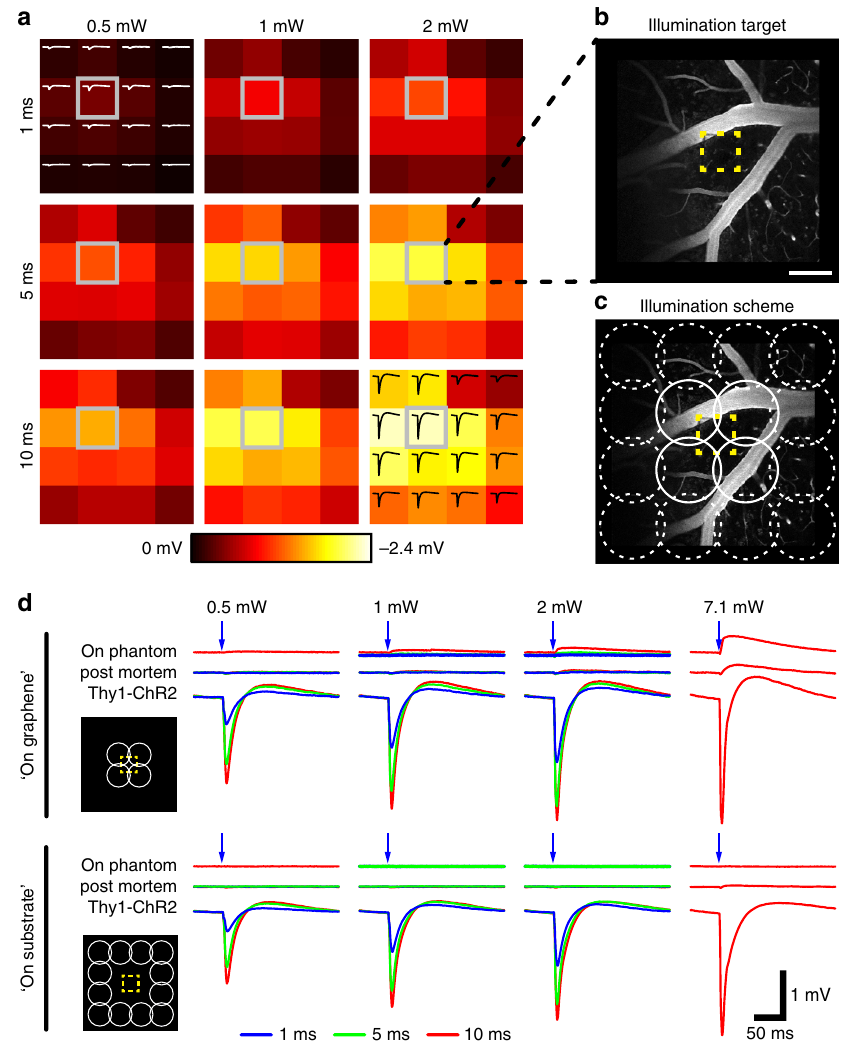
Fig. 5 Measurement of optogenetic photostimulation-induced electrical potentials in Thy1-ChR2 mice that express channelrhodopsin-2 (ChR2) in layer-V pyramidal neurons. a A 473 nm laser beam (diameter: 210 µ m full-width half-maximum) was sent through a 20× objective next to one graphene electrode (highlighted in gray). Different illumination times (1, 5, and 10 ms) and powers (0.5, 1, and 2 mW) were used. Heatmaps represent maximal response amplitude of the 16 electrodes in the array; example traces are shown for 0.5 mW/1 ms (top left) and 2 mW/10 ms (bottom right). b Two-photon image of the illumination target after intravascular injection of FITC-dextran (2 MDa); the yellow outline indicates the position of the graphene electrode. Scale bar, 100 µ m. c Per condition, illumination with the 473 nm laser beam was targeted to 12 sites “ on substrate ” (circles with broken lines) and to four sites “ on graphene ” (circles with closed lines) where the laser beam directly irradiates part of the electrode (yellow outline). d Electrical response of the single graphene electrode within the illumination target in a live Thy1-ChR2 mouse ( “ Thy1-ChR2 ” ), in the same animal after death ( “ post mortem ” ), and in vitro on an agarose phantom ( “ on phantom ” ). Laser pulses of 1, 5, and 10 ms length with powers of (0.5, 1, 2, and 7 mW) were used. Average responses of 12 “ on substrate ” or 4 “ on graphene ” illuminations per condition are shown; averaged responses from “ on substrate ” illuminations were used for response amplitude comparison across the microelectrode array as shown in